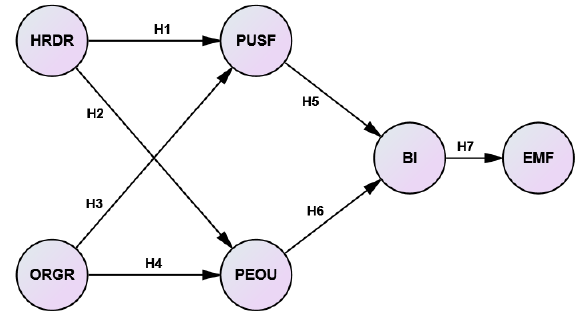
Fig. 2. Research conceptual